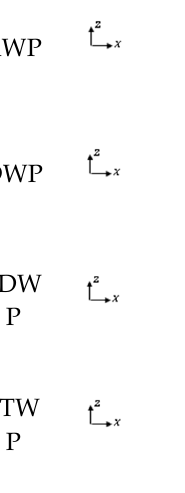
Figure 10. Air temperature distribution on an entire xz plane that is 0.1 mm above the solid fin surface for the plate-fin with (a) RWP, (b) DWP, (c) SDWP, and (d) STWP VGs at an airflow velocity of 5 m/s.